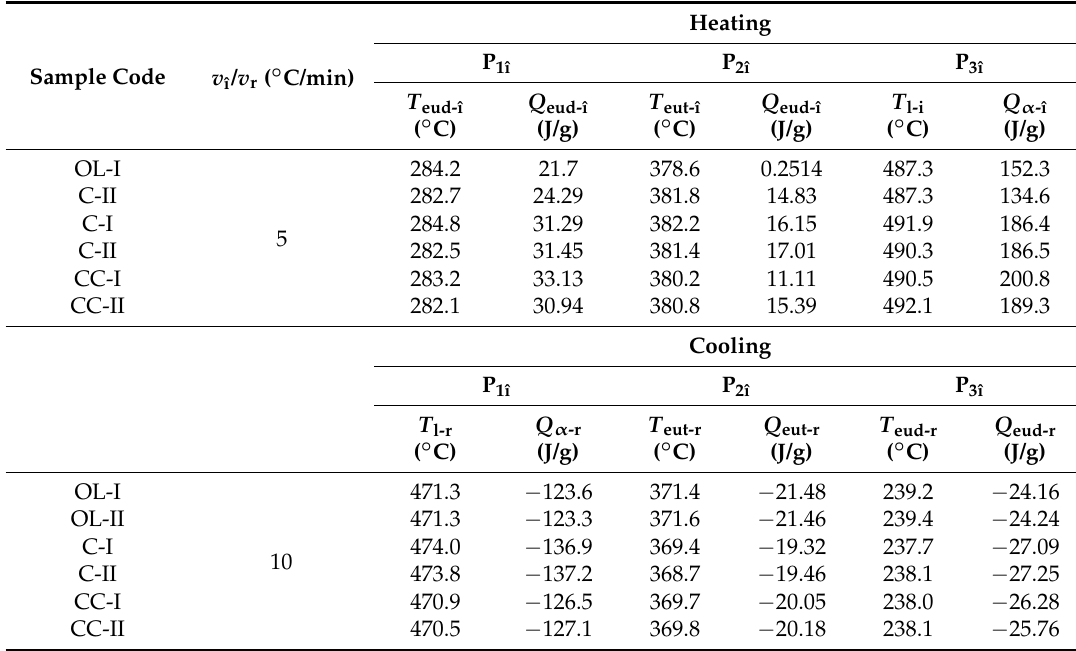
Table 4. Summary of the DSC analysis Table 4 . Summary of the DSC analysis results.